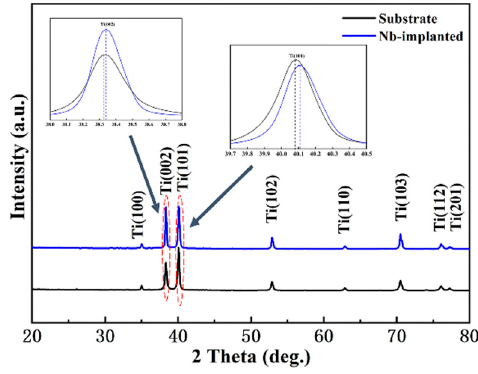
Figure 2. XRD patterns of substrate and the Nb-implanted sample.